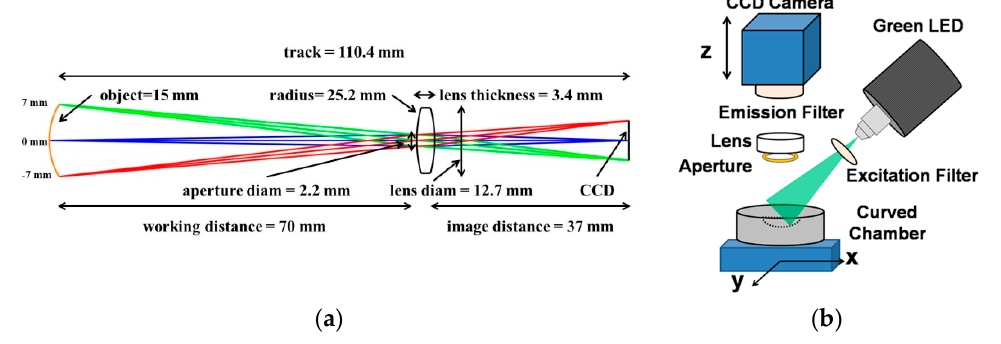
Figure 1. ( a ) Optical prescription for prototype curved-substrate imaging system, designed for a wavelength of 560 nm. A single commercial lens was used for imaging. All dimensions are in millimeters. ( b ) Schematic of experimental setup.